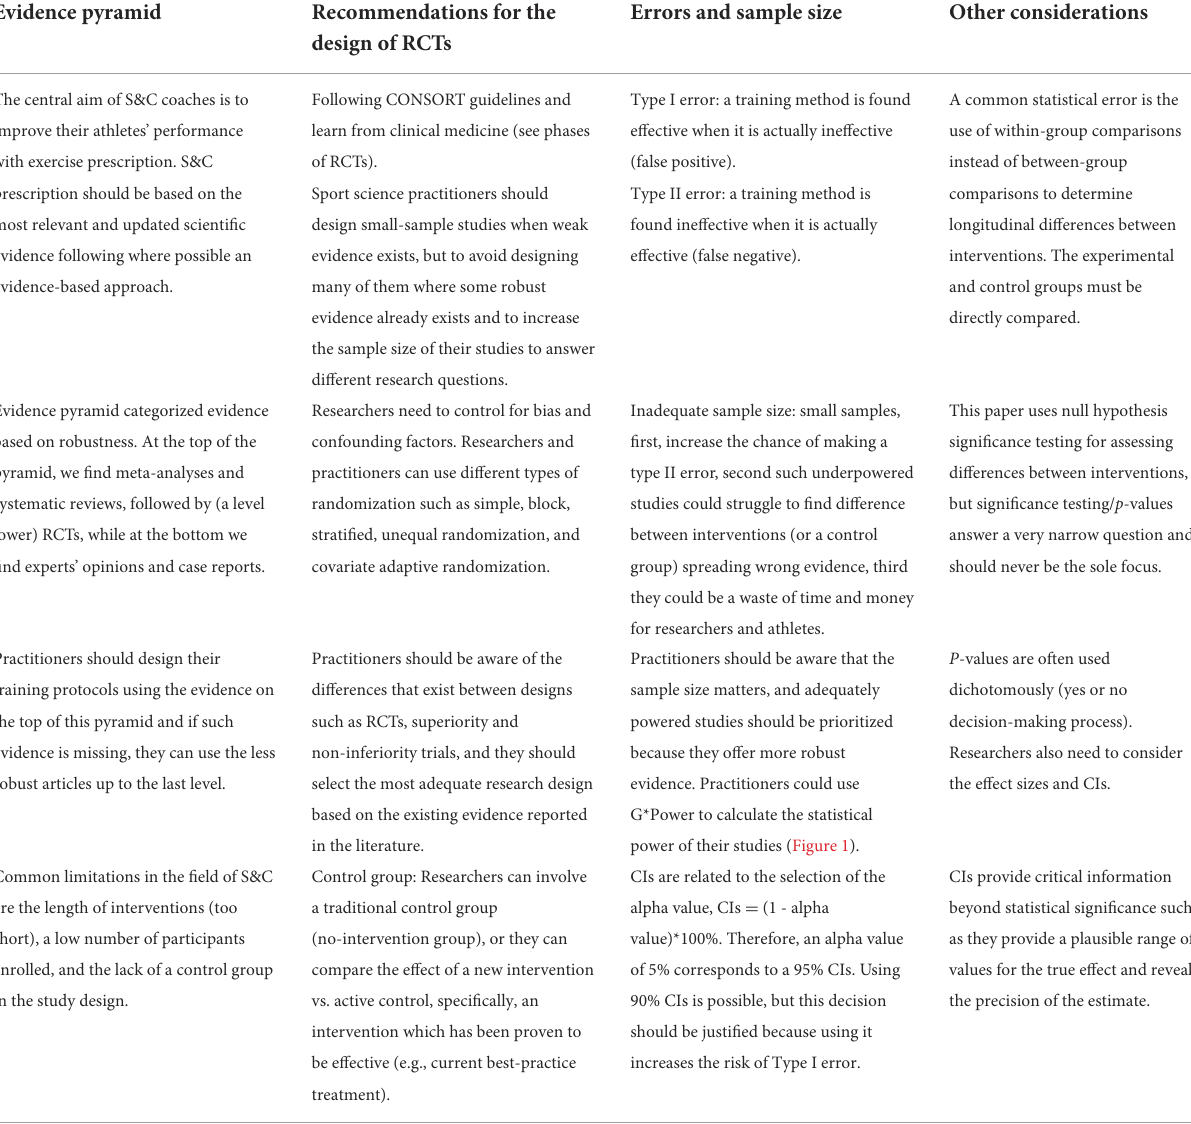
TABLE 1 Summary of the recommendations for the design of randomized controlled trials and data interpretation in strength and conditioning. Evidence